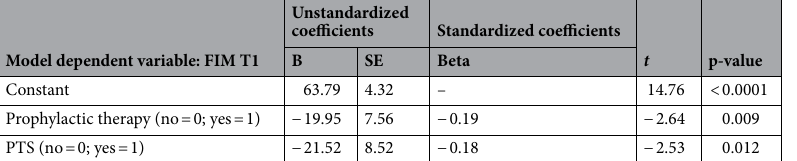
Model dependent variable: FIM T1